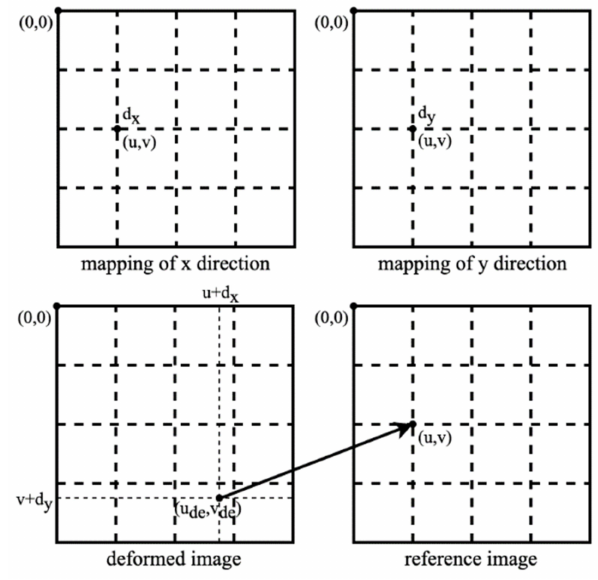
Figure 3. Mechanism of point-to-point mapping.